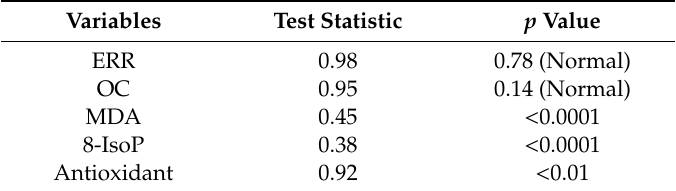
Table 3. Normality test (Shapiro–Wilk test) showing distribution of job stress indicators and oxidative stress biomarkers.